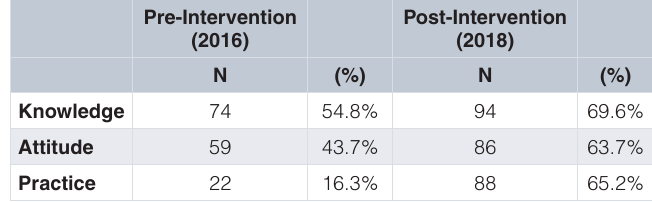
Table 3. Overall knowledge, attitude & practices regarding infant and young child feeding (IYCF) nutrition among pregnant & lactating women in rural Islamabad, during 2016–2018